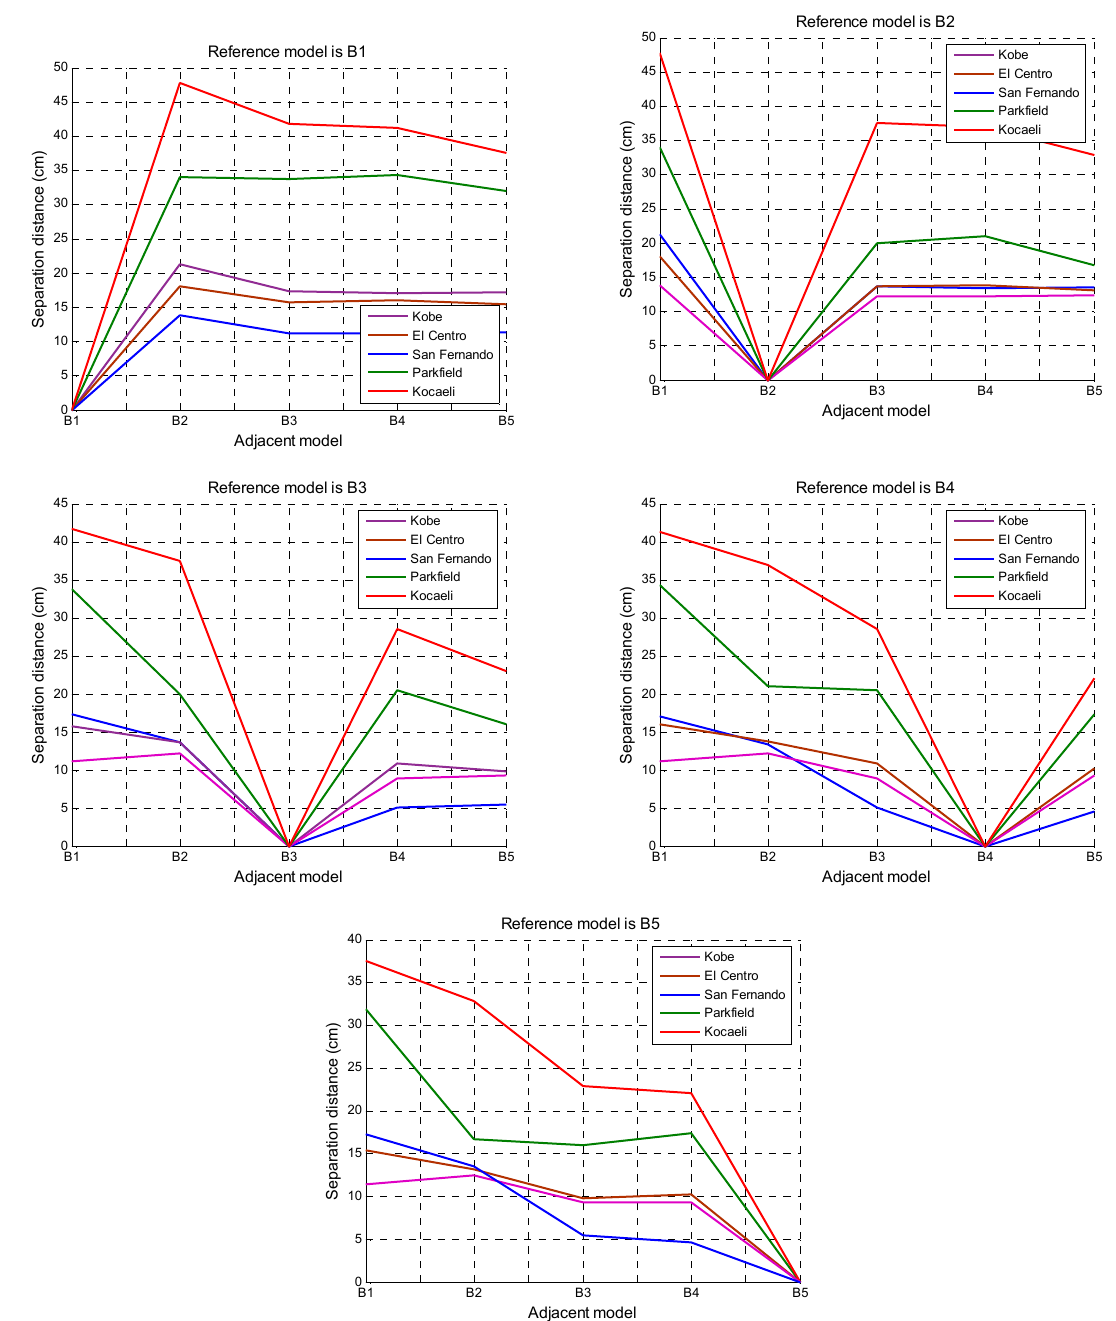
Figure 3. Estimated separation distance using the CRVK program for different models under various ground motions.